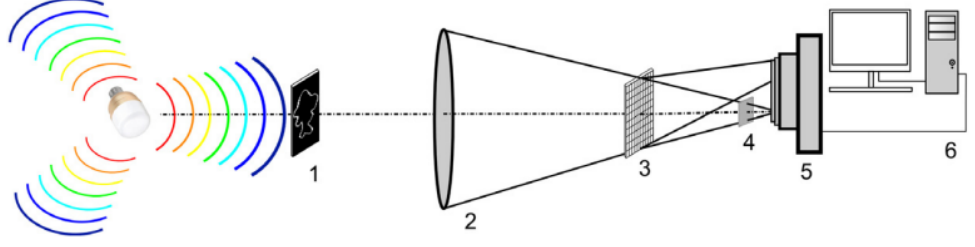
Figure 10. Setup of the incoherent light optical correlator proposed by Cheremkhin et al. [56]. 1: object to be recognized; 2: lens; 3 and 4: holographic and neutral filters, respectively; 5: camera; 6: